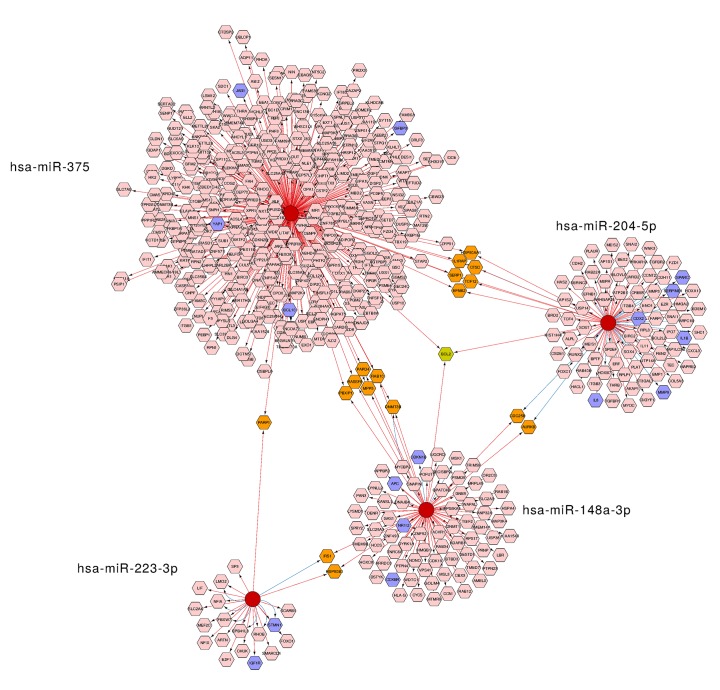
Expression levels of BCL2 and DNMT3B in GC tissue and correlation analysis with their putatively targeting miRNAs.(a) Expression levels of BCL2 and DNMT3B was analyzed using qRT-PCR. The data are represented as log2 2-(deltaCt) values; Pearson correlation analysis: (b) between relative expression levels of DNMT3B and relative expression levels miR-375; (c) between relative expression levels of DNMT3B and relative expression levels miR-148a-3p; (d) between relative expression levels of BCL2 and relative expression levels miR-148a-3p; (e) between relative expression levels of BCL2 and relative expression levels miR-204-5p; (f) between relative expression levels of BCL2 and relative expression levels miR-375 in gastric tissue samples. P value below 0.05 was considered significant.